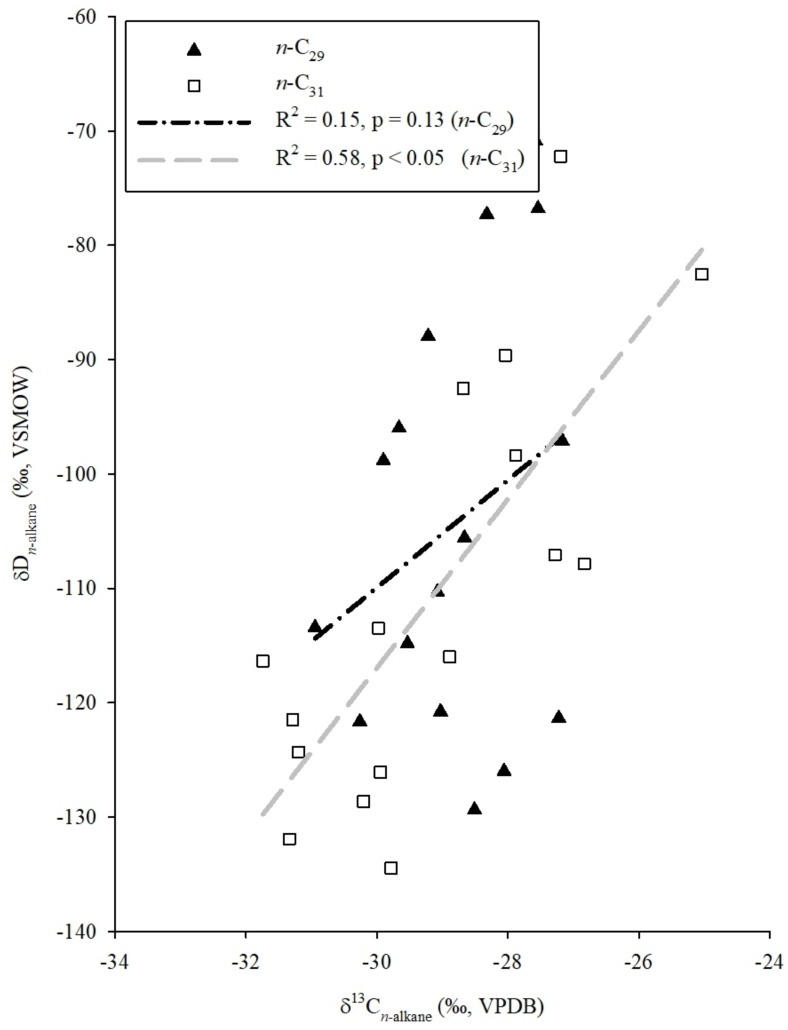
Regression analyses between δDn-alkane and δ13Cn-alkane values for C29 and C31 homologues.Poor correlation (blue line) between the δDn-alkane and δ13Cn-alkane values for C29 homologue indicates limited control of vegetation composition on the δDn-alkane values. Strong and significant positive correlation (red line) between the δD and δ13Cn-alkane values for C31 homologue also suggests that change in vegetation type does not have influence on the δDn-alkane values in collected samples.